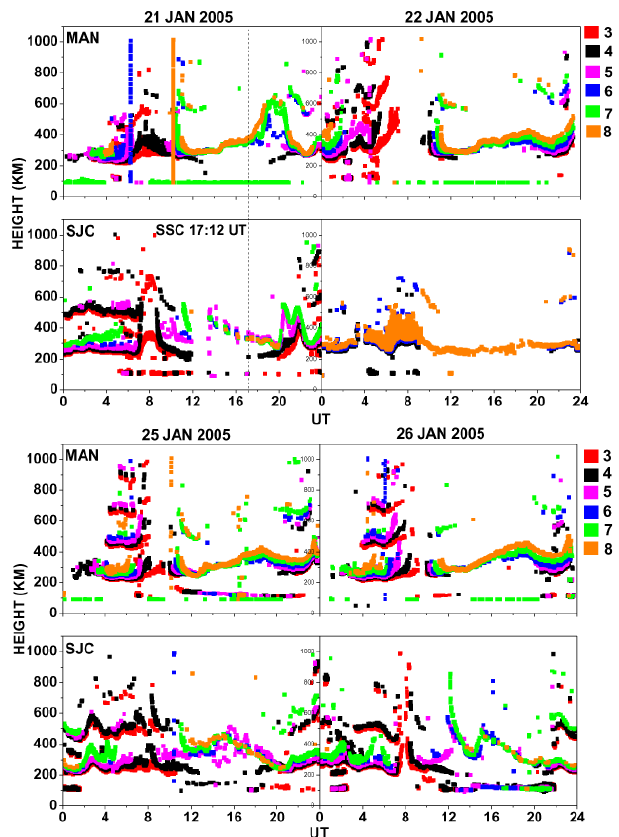
Fig. 8. Plots of virtual height variations for six different frequencies (3 to 8MHz) (Iso-frequencies) observed at Manaus (top panel) and S. J. Campos (bottom panel) for UT days 21, 22, 25, and 26 January